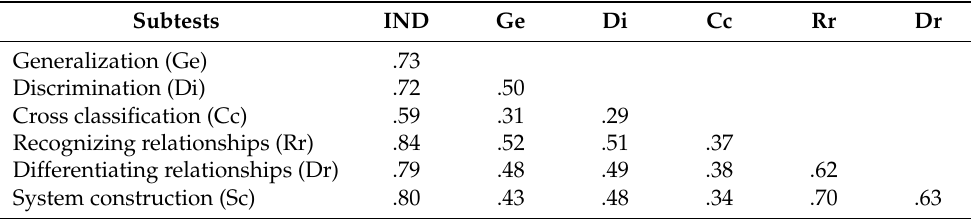
Table 4. Correlations among Inductive reasoning strategies test and its subtests.